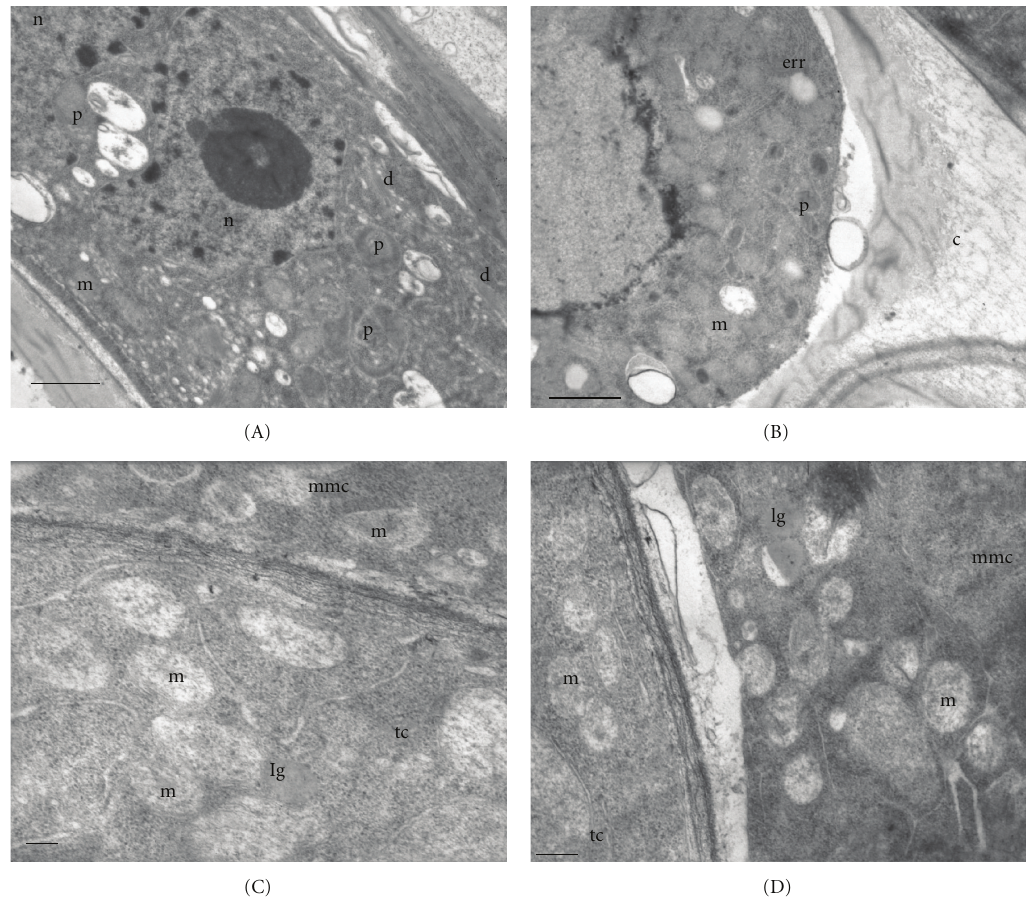
Figure 1: Stage 1: microspore mother cells (MMCs). (A)-(B) Colletia paradoxa. (C)-(D) Discaria americana . (A) Tapetal cell with two nuclei (n), plastids (p), dictyosomes (d), and mitochondria (m). (B) Details of the microspore mother cell: plastids (p), mitochondria (m), endoplasmic reticulum of rough type (err), and callose (c). (C) Microspore mother cell (mmc) and tapetal cell (tc) with mitochondria (m) and lipid globules (lg) (D) Microspore mother cell with lipid globules (lg). and mitochondria (m). Scale bar; (A)-(B) 1.3 µ ; (C) 200 nm (D)